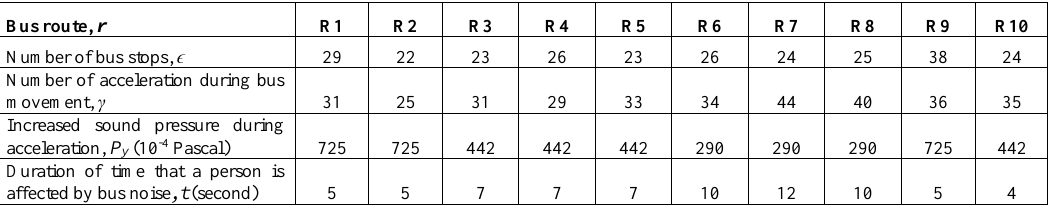
Table 3. Data input to quantify bus noise [30,